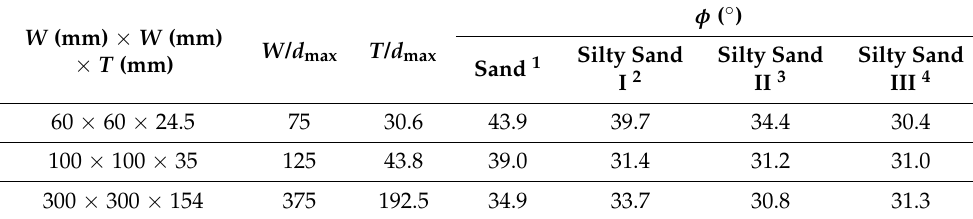
Table 7. Friction angles of sand and silty sands, obtained by only considering the direct shear test results of Ziaie Moayed et al. [34] with the normal stresses of 109, 163, and 218 kPa.